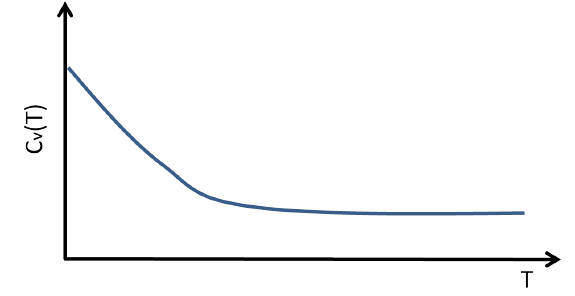
Figure 2: Conceptual image of relationship between Cv ( T ) and